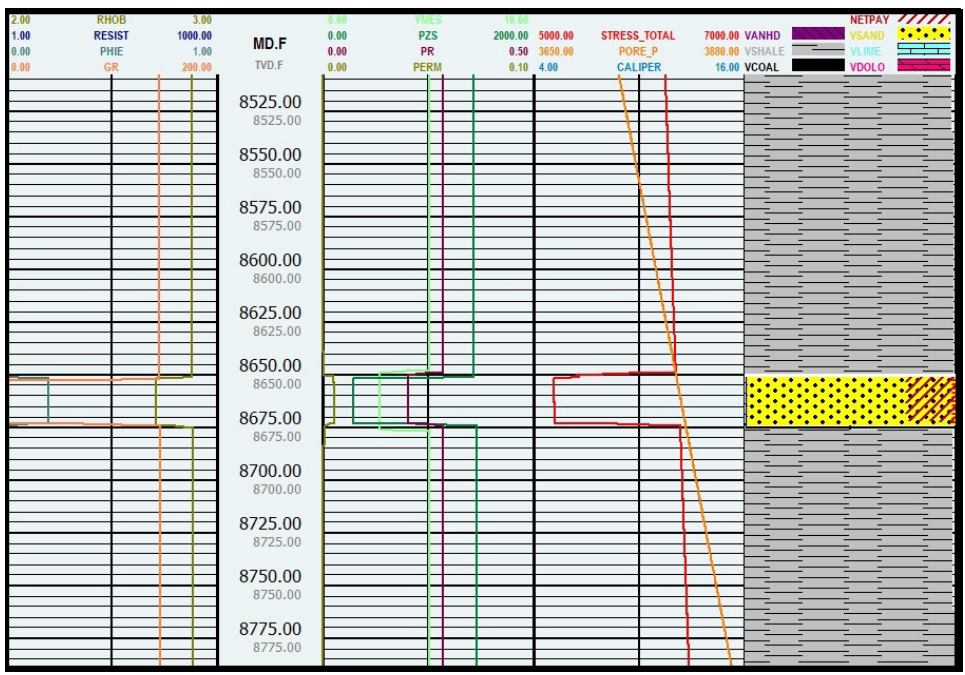
Figure 7. The mechanical Earth model and reservoir properties for the fracture simulation model used to test the CWT closure detection technique.